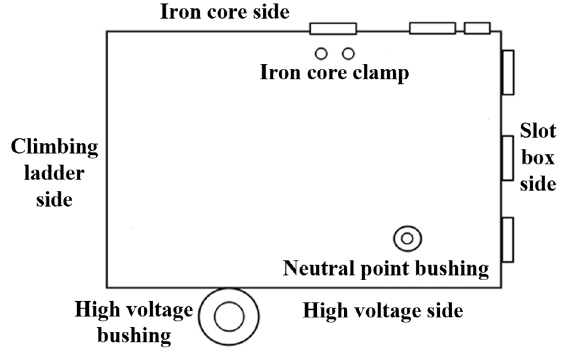
Figure 1. Layout plan of reactor acoustic–electric sensors.